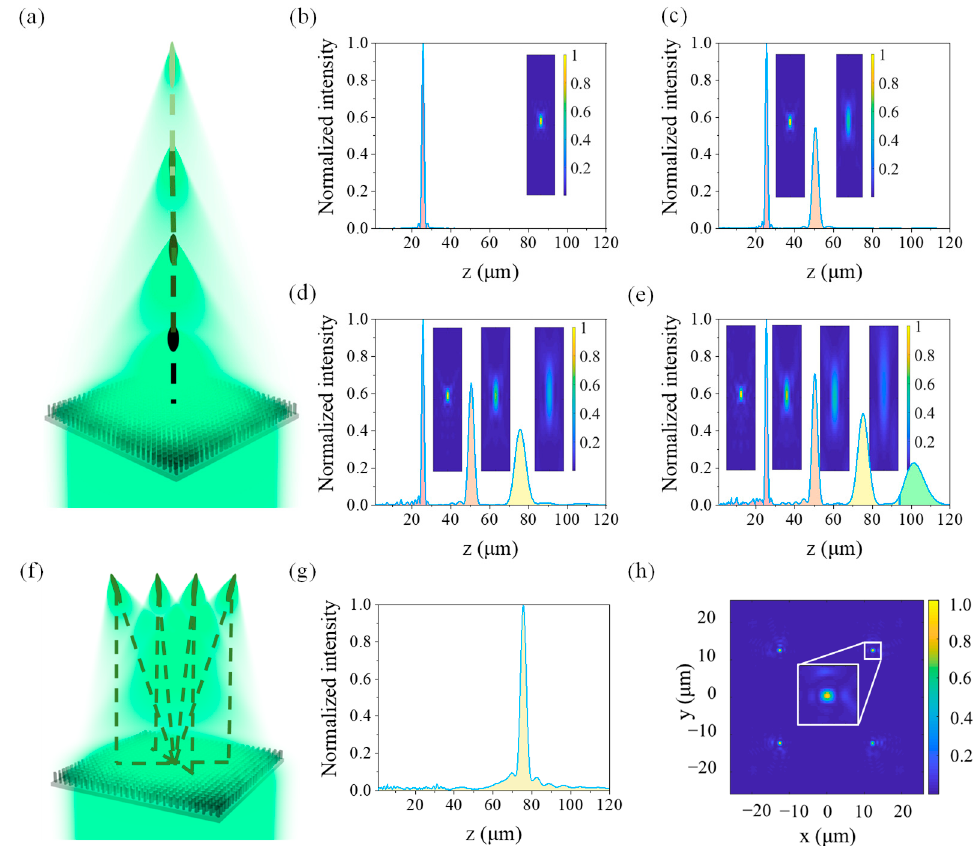
Figure 3. Multifocal metalenses with different focal points. ( a ) Four focal points are arranged in the vertical direction of a metalens. ( b ) A single focal point metalens ( f = 25 µ m). ( c ) A multifocal metalens with two focal points ( f = 25 µ m and 50 µ m). ( d ) A multifocal metalens with three focal points ( f = 25 μ m, 50 μ m, and 75 μ m). ( e ) A multifocal metalens with four focal points ( f = 25 μ m, 50 μ m, 75 μ m, and 100 μ m). ( f ) Four focal points are arranged in the horizontal direction (all their focal points are in the plane of z = 75 μ m) of a metalens. ( g ) Intensity curve of a horizontal multifocal metalens along the z axis. ( h ) Normalized light intensity distributions on the z = 75 μ m plane.